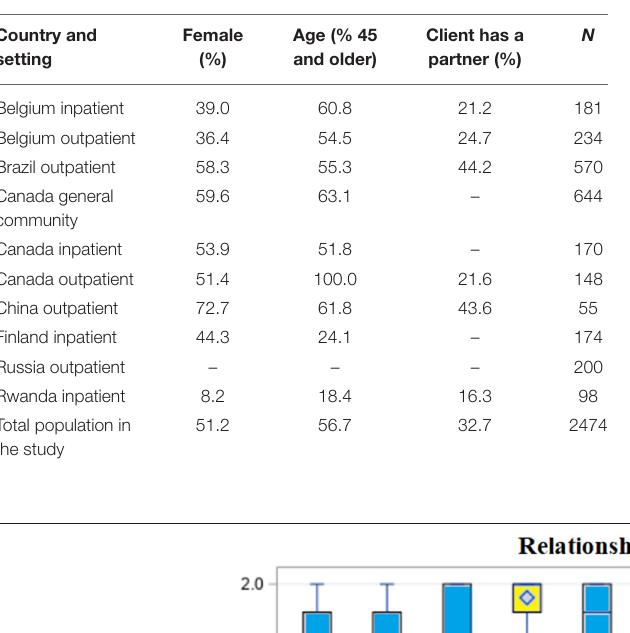
TABLE 1 | Characteristics of the samples of the participating countries and settings.